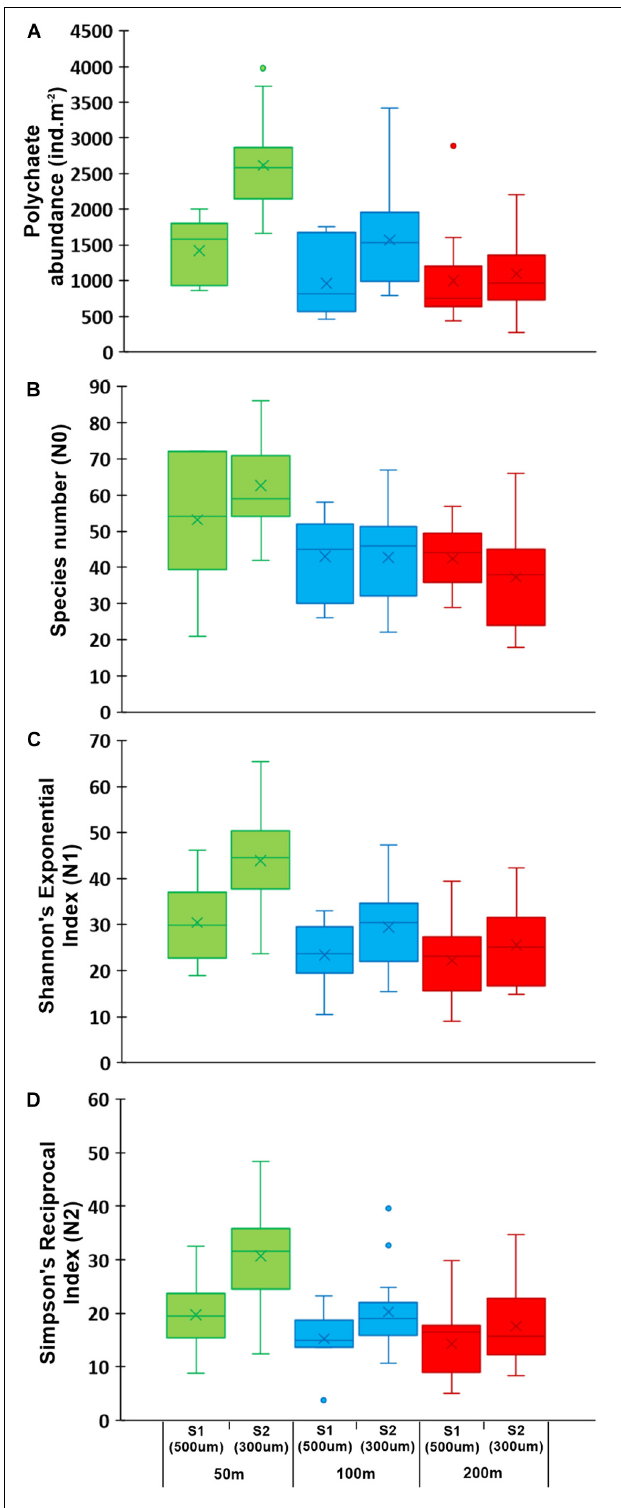
FIGURE 5 | Box-and-whisker plots showing (A) polychaete abundance, (B) species number (N0), (C) Shannon’s exponential index (N1), and (D) Simpson’s reciprocal index (N2) at 50 m (green), 100 m (blue), and 200 m (red) depth strata in survey 1 (500 µ m) and survey 2 (300 µ